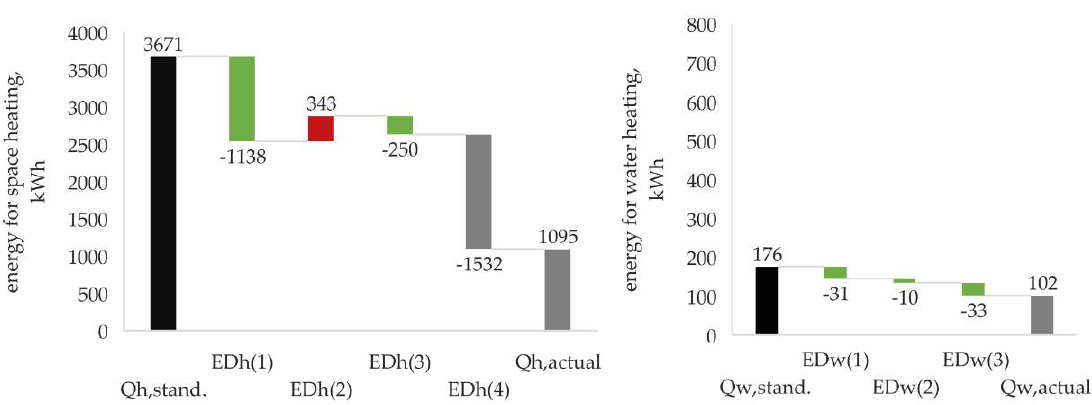
Figure 6. Influence of individual parameters on the values of energy consumption for heating ( Q h ) and hot water preparation ( Q w ) for unit B. and hot water preparation ( Q w ) for unit